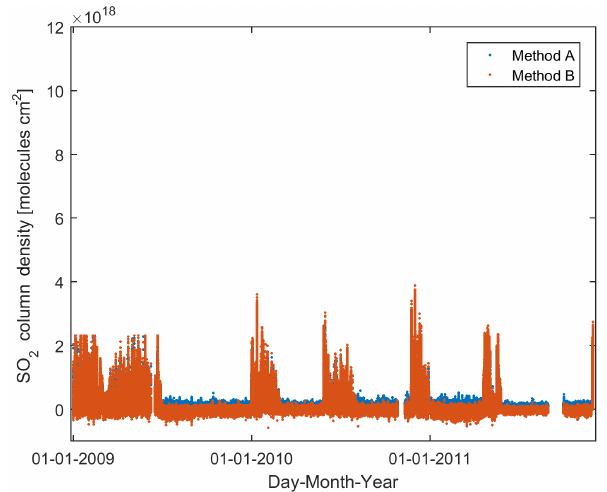
Figure B5. SO 2 CD time series for instrument I2J8548 at Tungu-